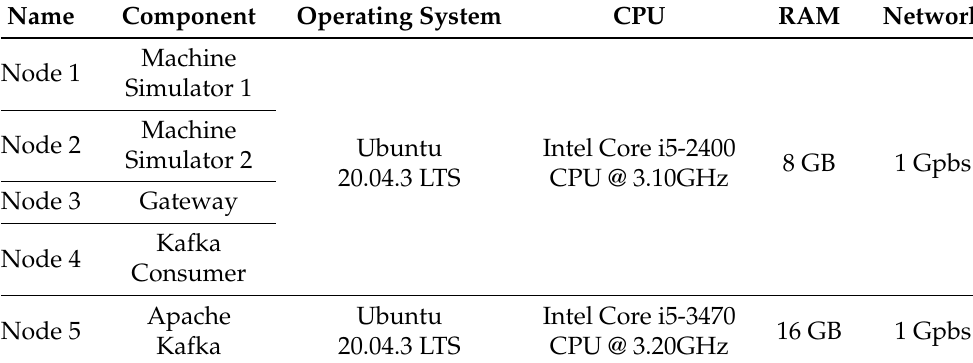
Table 1. Testbed deployment: components, OS, and hardware